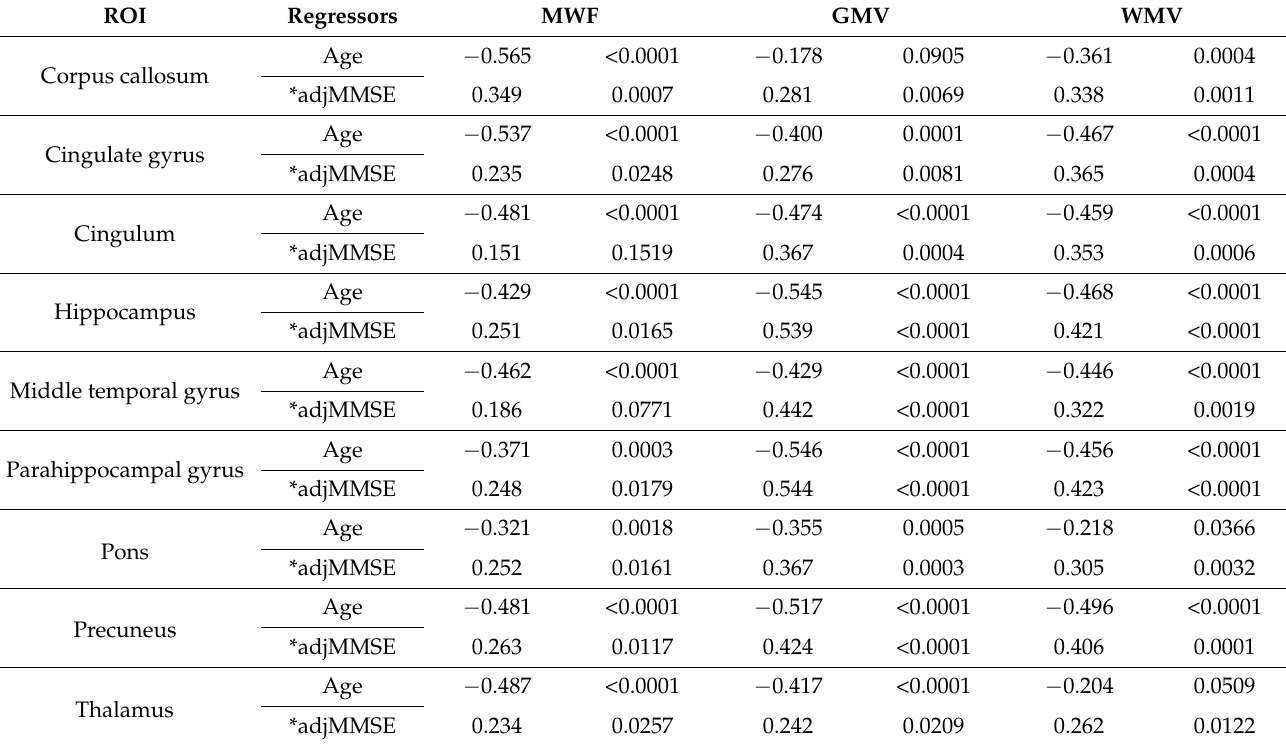
Table 3. Results of correlation analysis between MRI measures in specific brain areas and age or MMSE